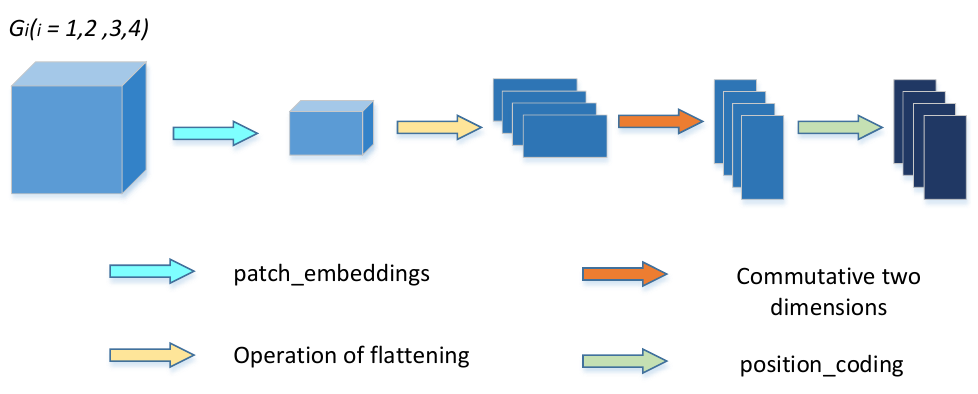
Figure 4. Multiscale feature embedding process.